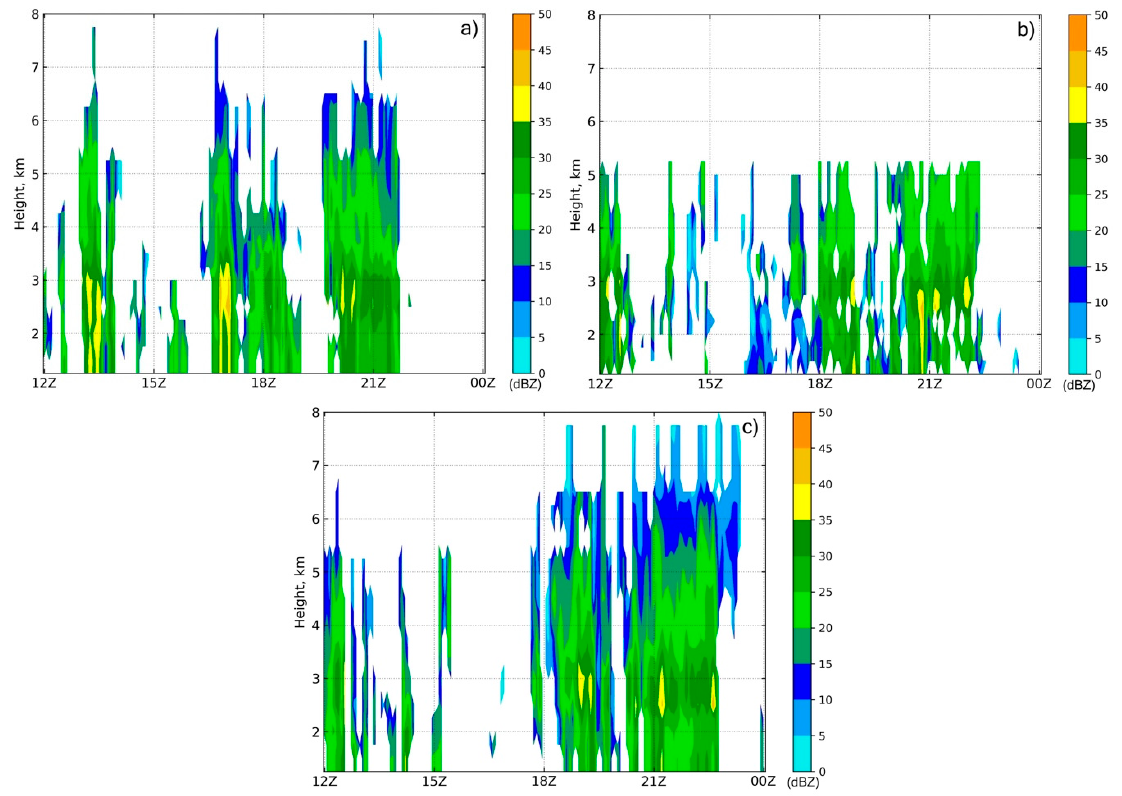
Figure 5. Time-height cross section of observed Z H for ( a ) Huddart Park, ( b ) San Jose, and ( c ) Biel Ranch starting 16 November 2017 at 12:00 UTC.